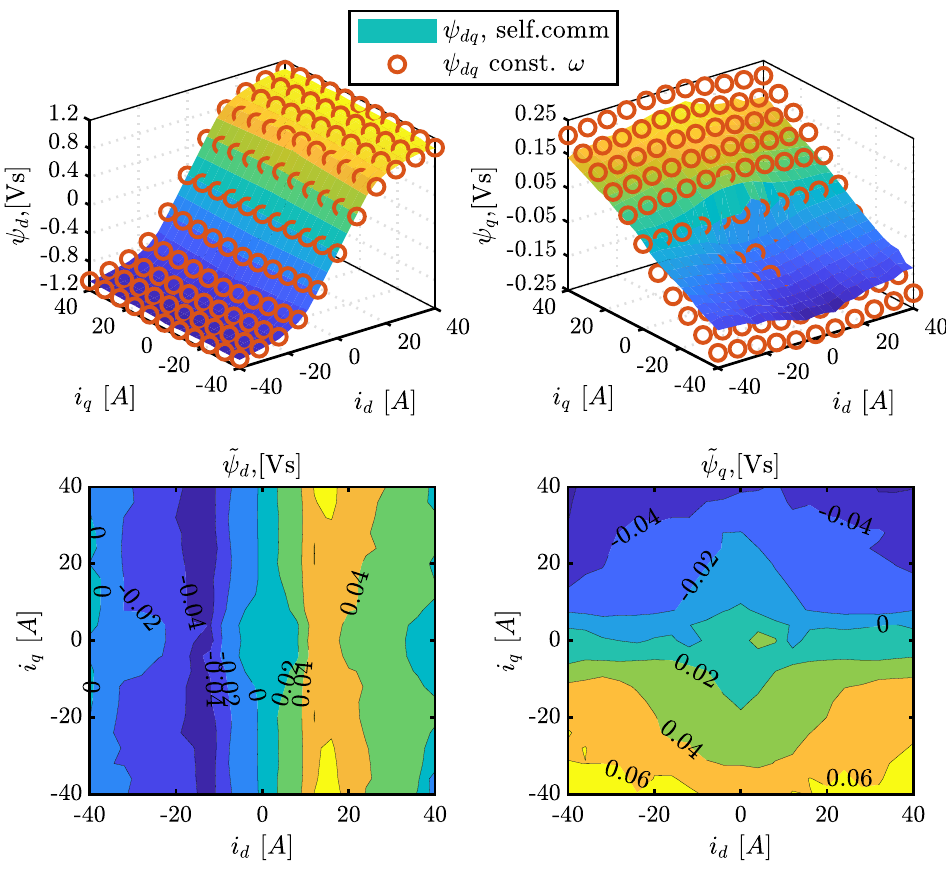
Figure 18. Comparison between identified and reference flux maps.